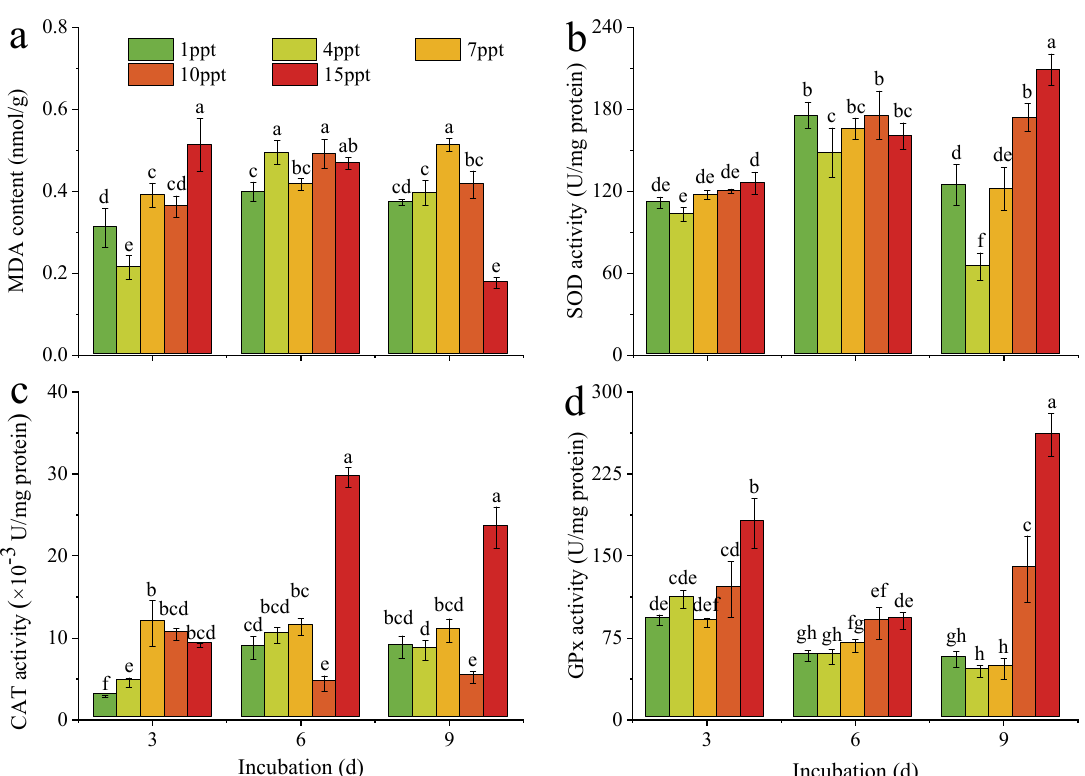
Figure 5. MDA content ( a ), and enzyme activity of SOD ( b ), CAT ( c ) and GPx ( d ) of M . aeruginosa under different salinity stresses on days 3, 6 and 9. Different letters a–h in the histogram indicate significant differences (ANOVA, p < 0.05).